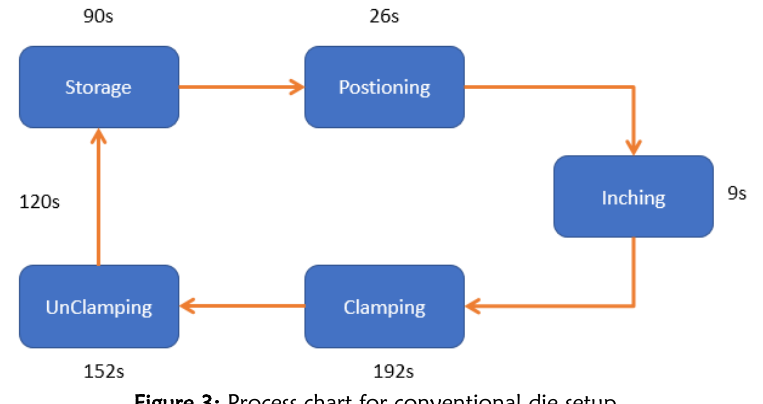
Figure 3: Process chart for conventional die setup